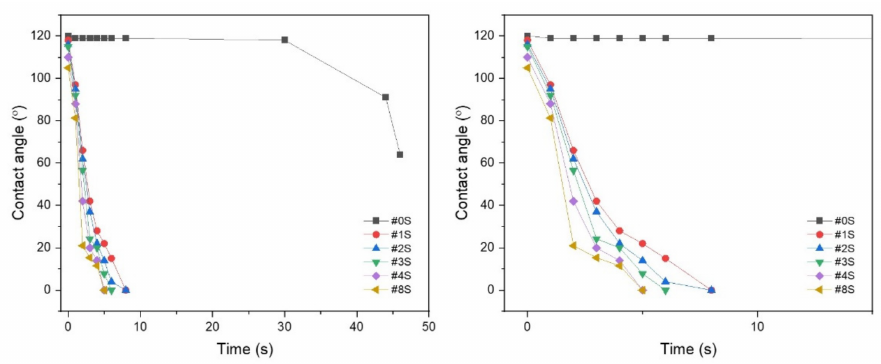
Figure 3. Contact angle the electrospun PLA/PEG-PPG-PEG/SiO 2 nanofibrous adsorbents containing the various concentrations of SiO 2 .